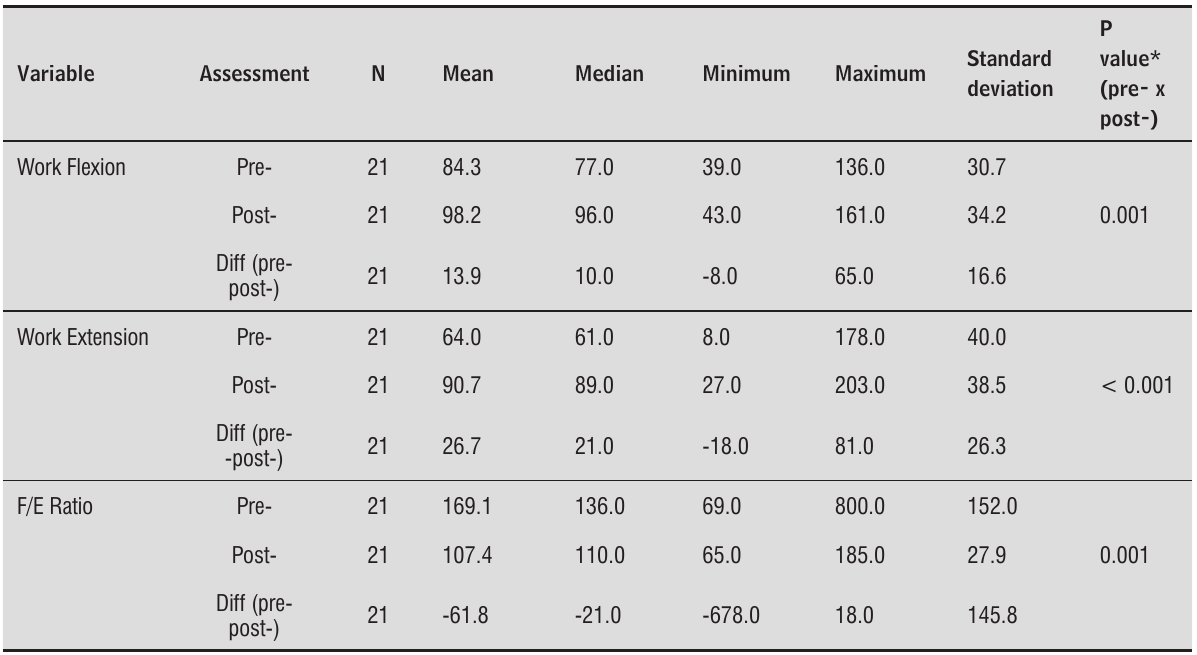
Table 3 - Descriptive statistics of the variables torque peak, work in flexion and extension, F/E ratio, and p values